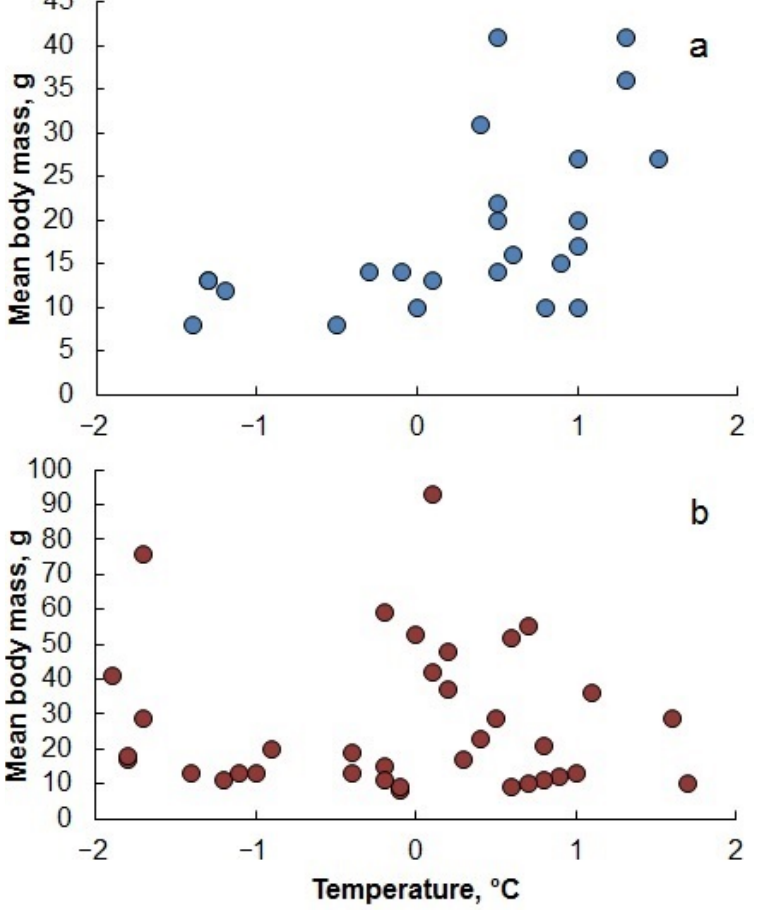
Figure 8. Mean body mass (g) of ice cod Arctogadus glacialis across fjord ( a ) and shelf ( b ) stations in Northeast Greenland in relation to ambient temperature (cf. Table 1 and Figures 1 and 3).